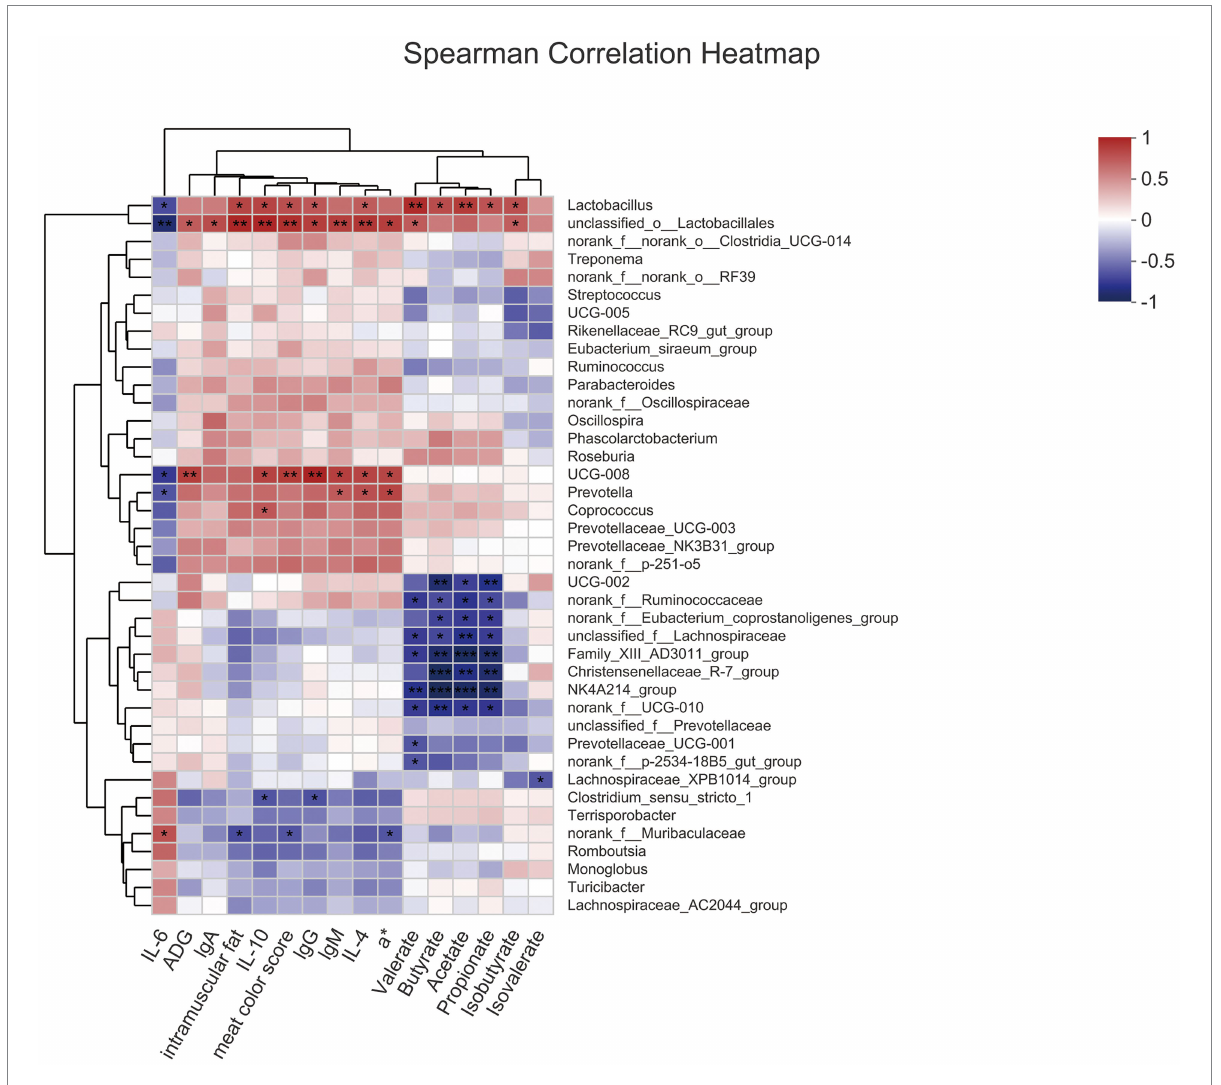
FIGURE 4 Spearman’s correlation among gut microbiota, serum index, meat quality and SCFAs. * and ** represented significant differences ( p < 0.05) and ( p < 0.01) from indicated control groups,